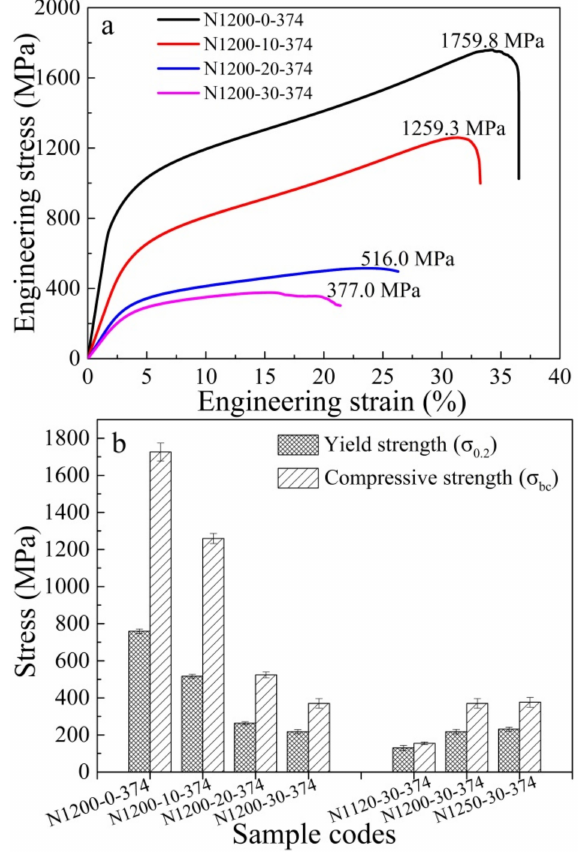
Figure 7. Engineering stress-strain curves for the porous HNASSs with various amounts of space holder ( a ); Yield strength and compressive strength of the porous HNASSs with various sintering temperatures and amounts of space holder ( b